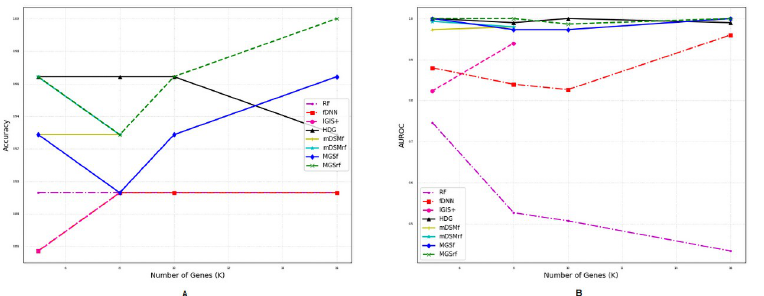
Fig 5. Performance comparison using different number of selected genes for the GDS3610 dataset. (A) Accuracy. (B) AUROC.